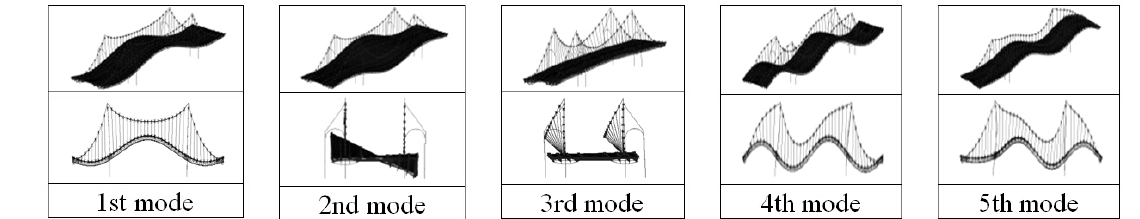
Figure 5. The first five modal shapes of main girder of Hunan Road Bridge from FE model.